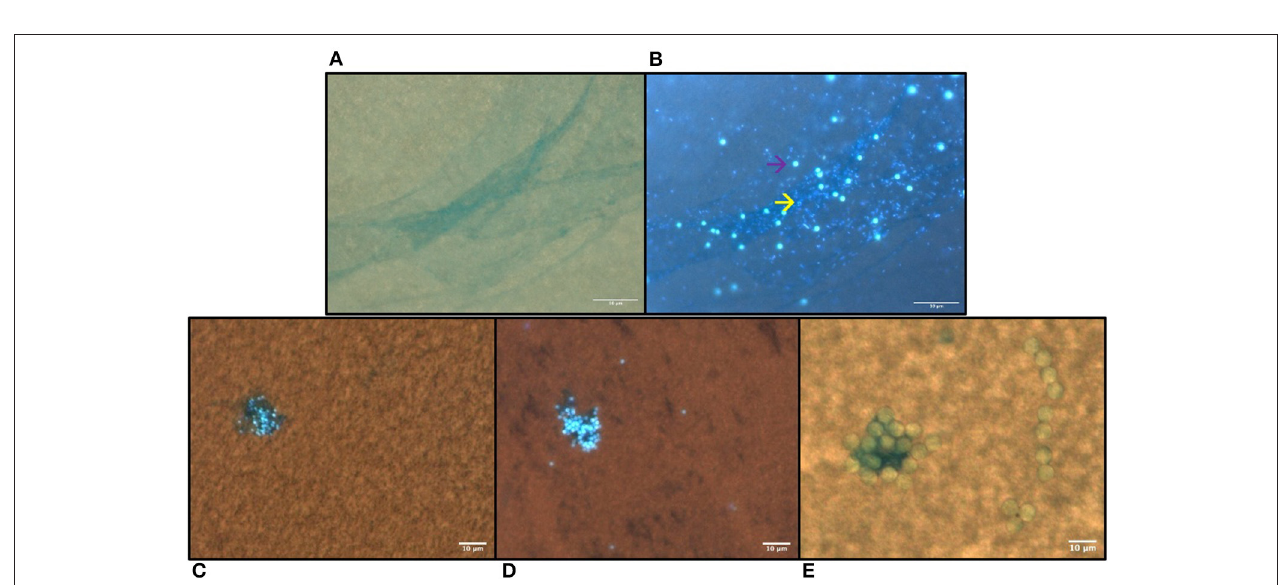
FIGURE 2 | Microplastic aggregation formed after 72h of incubation in prefiltered natural freshwater stained with alcian blue and DAPI. (A) Transparent exopolymer particles (TEP) stained with alcian blue and DAPI in 1 µ m MS sample visualized under bright light and (B) under UV-light, the yellow arrow indicates the bacteria and the purple arrow indicates the MS; (C) 1 µ m, (D) 3 µ m MS aggregation visualized with merged UV-light and bright light (E) 6 µ m. The microspheres are visible also under the UV light (B–D) . The scale bar is 10 µ